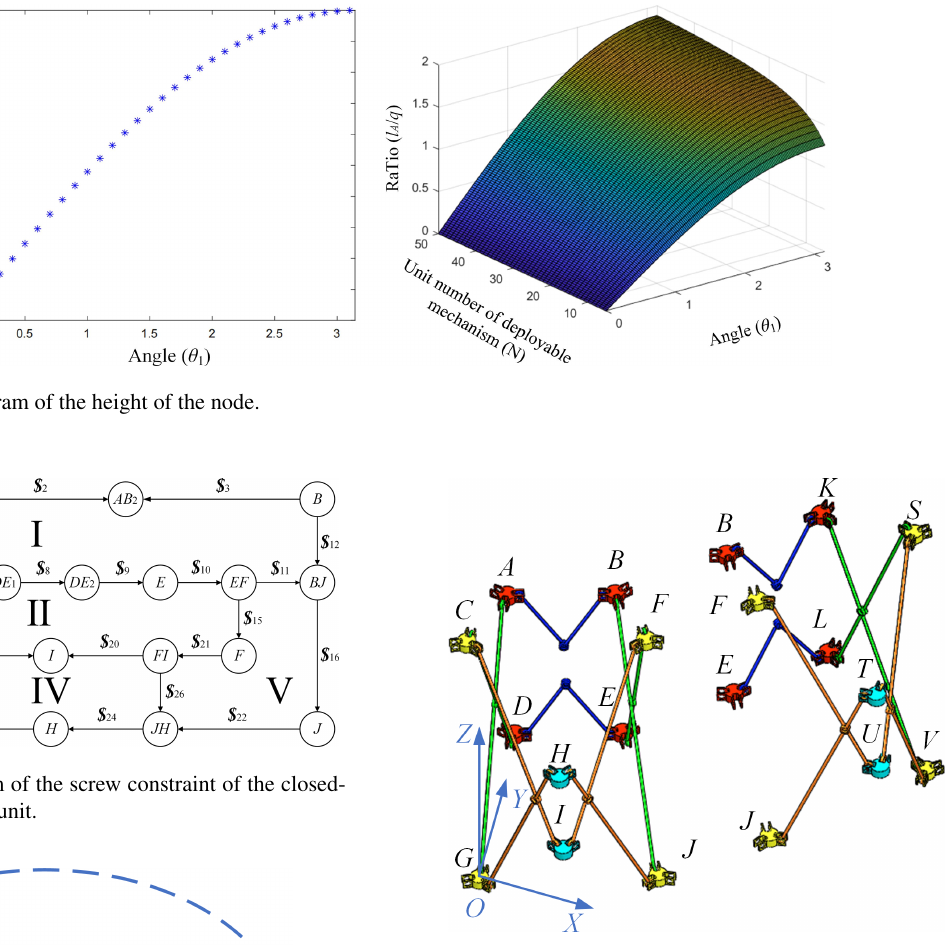
Figure 11. Combined mechanism and the associated coordinate system.